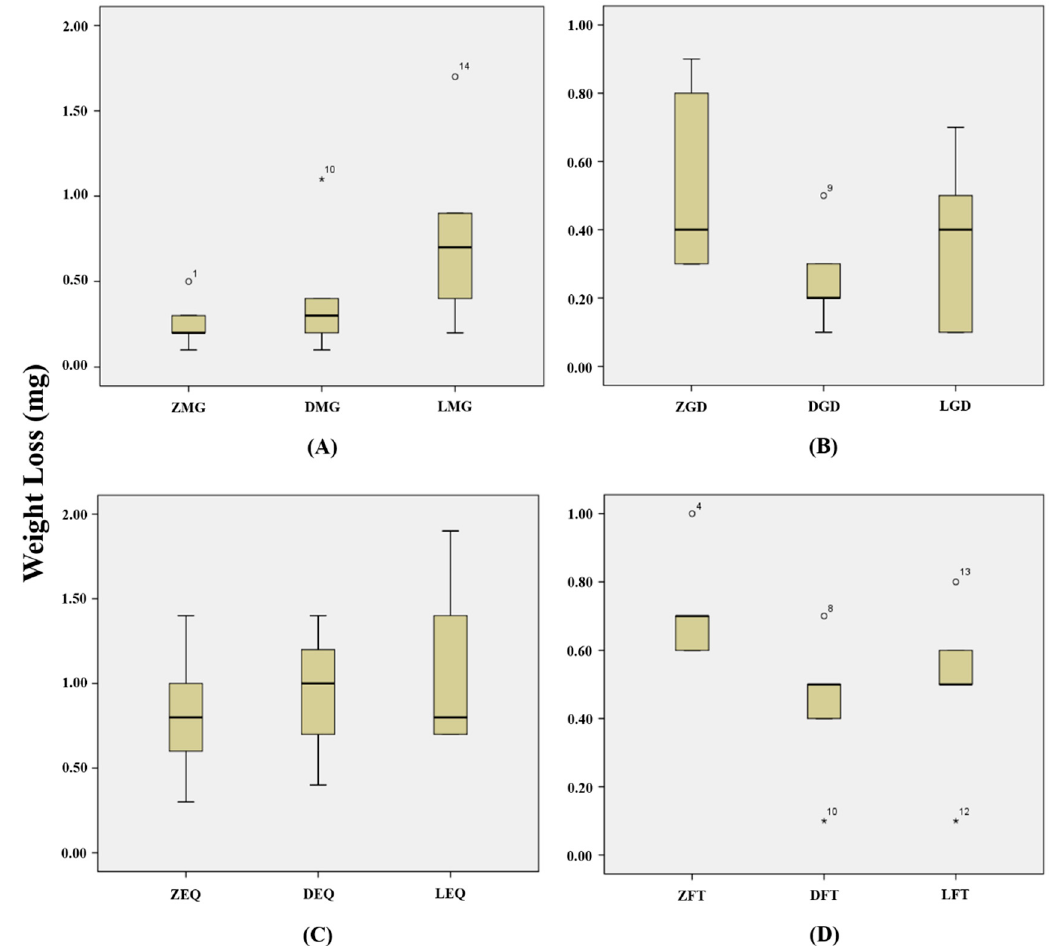
Figure 7. Weight losses of composite resin specimen (mg): ( A ) Weight losses of MG when opposing to ceramics; ( B ) Weight losses of GD when opposing to ceramics; ( C ) Weight losses of EQ when opposing to ceramics; ( D ) Weight losses of FT when opposing to ceramics. ZMG, zirconia opposing MI Gracefil; DMG, lithium disilicate opposing MI Gracefil; LMG, leucite opposing MI Gracefil; ZGD, zirconia opposing Gradia Direct P; DGD, lithium disilicate opposing Gradia Direct P; LGD, leucite opposing Gradia Direct P; ZEQ, zirconia opposing Estelite Σ Quick; DEQ, lithium disilicate opposing Estelite Σ Quick; LEQ, leucite opposing Estelite Σ Quick; ZFT, zirconia opposing Filtek Supreme Ultra; DFT, lithium disilicate opposing Filtek Supreme Ultra; LFT, leucite opposing Filtek Supreme Ultra.